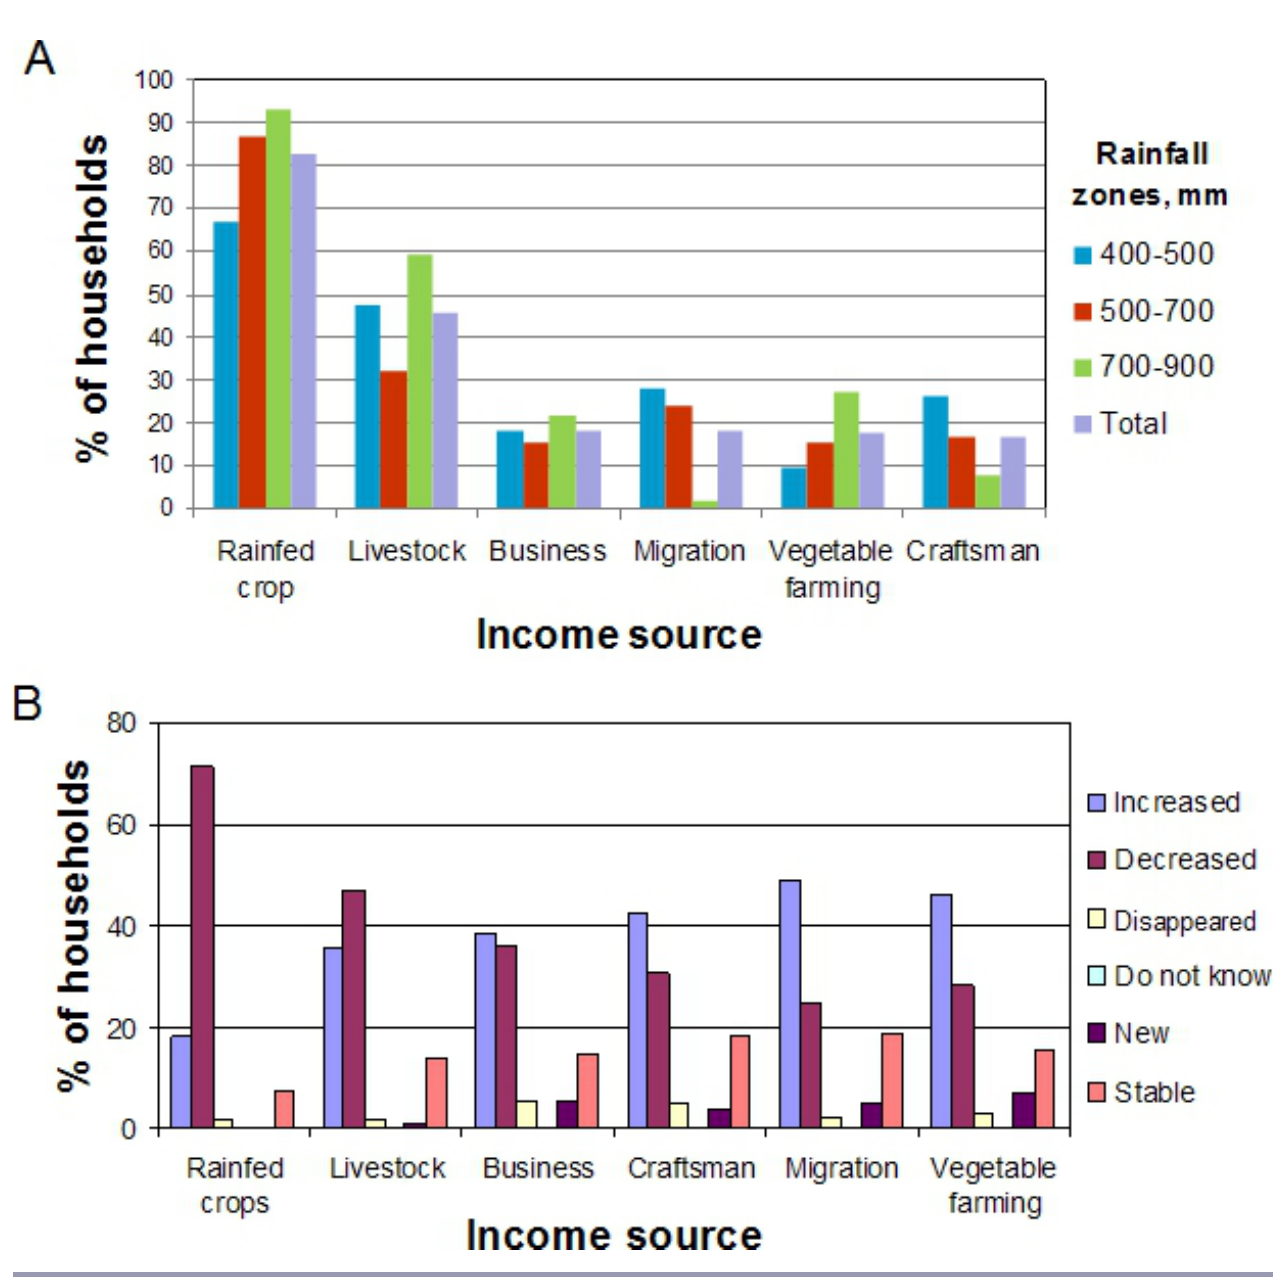
Fig. 2. Household income sources in the Sudan-Sahel zone of West Africa. a) Percent of households mentioning the six most important income sources (N=2477, p < 0.05). b) Percent of households expressing changes in the six main household income categories during the past 20